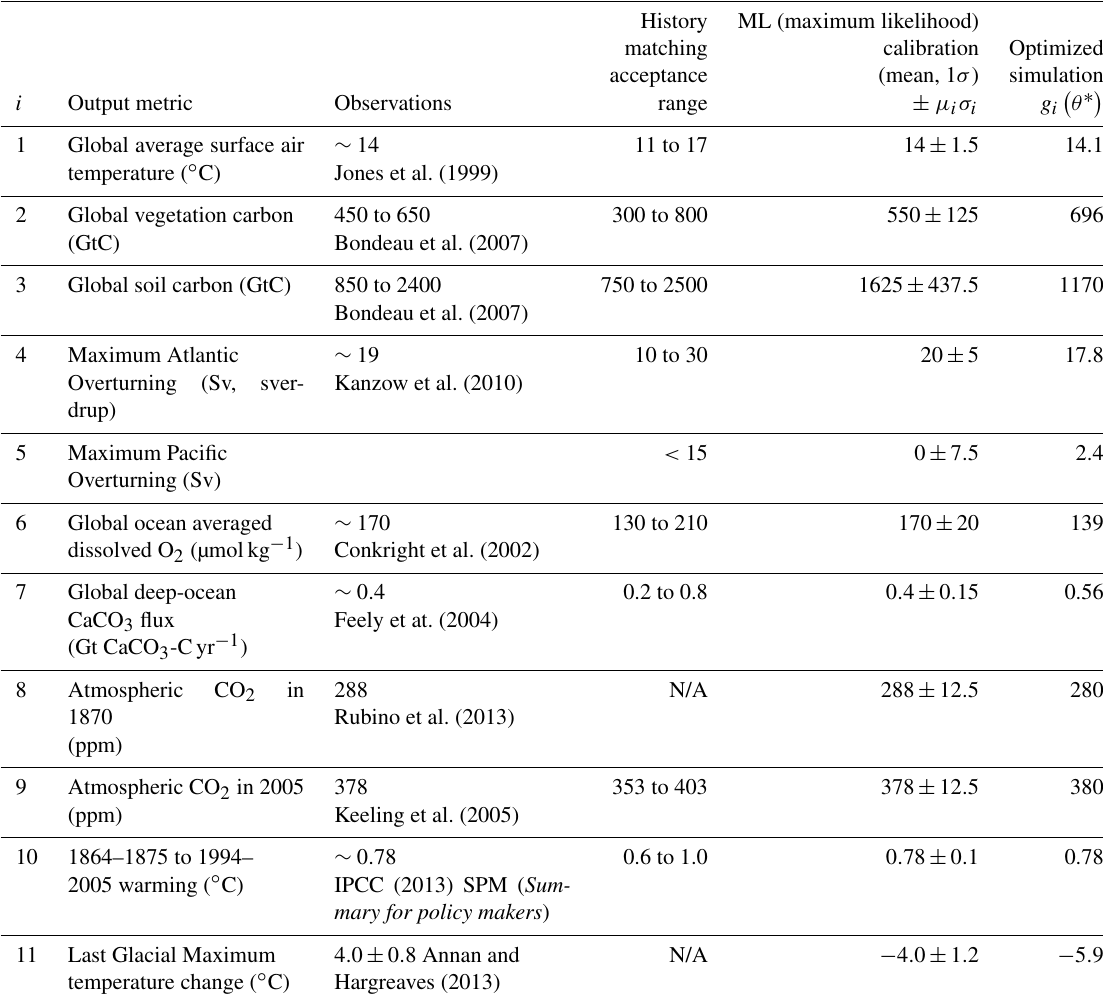
Table 1. Simulation output metrics for history matching and maximum likelihood